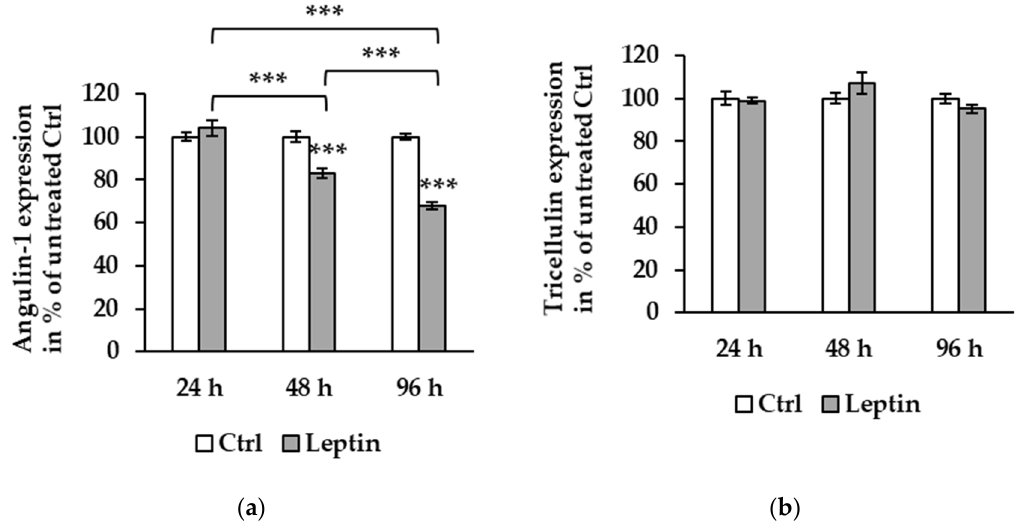
Figure 4. Effect of leptin on protein expression at different time points in Caco-2 cells. ( a ) Angulin-1 expression level exhibits reduction at 48 (82.38 ± 1.03%, *** p < 0.001, n = 12) and 96 h (67.71 ± 1.68%, *** p < 0.001, n = 12) of leptin treatment compared to untreated Ctrl. There is a significant difference between 24 and 48 h (*** p < 0.001), 48 (*** p < 0.001) and 96 h (*** p < 0.001), and 24 and 96 h. ( b ) Tricellulin expression is not affected by leptin at 24, 48, or 96 h.